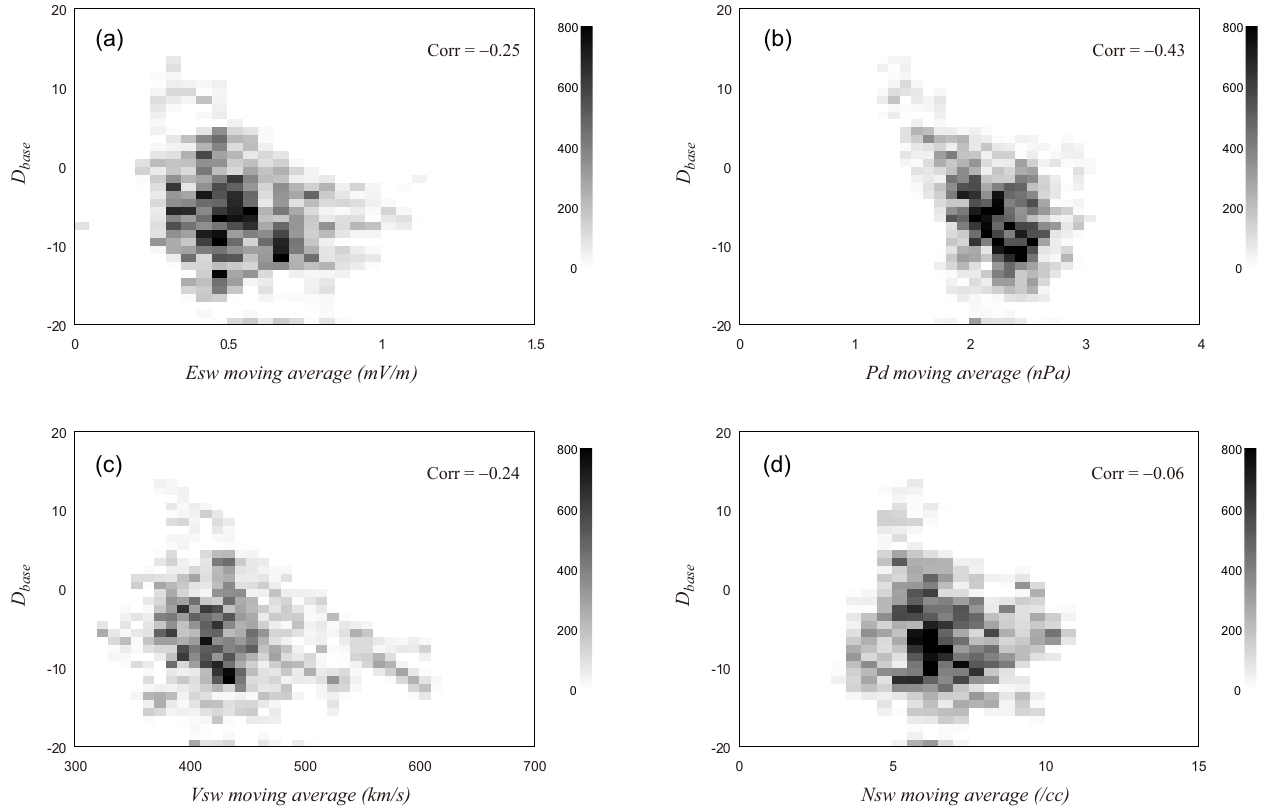
Fig. 6. Two-dimensional histograms comparing D base and the 30-day moving averages of solar-wind parameters: (a) electric field, (b) solar- wind dynamic pressure, (c) speed, and (d) number density. The correlation coefficient with D base was − 0.25 for the solar-wind electric field, − 0.43 for the solar-wind dynamic pressure, − 0.24 for the solar-wind speed, and − 0.06 for the solar-wind number density.